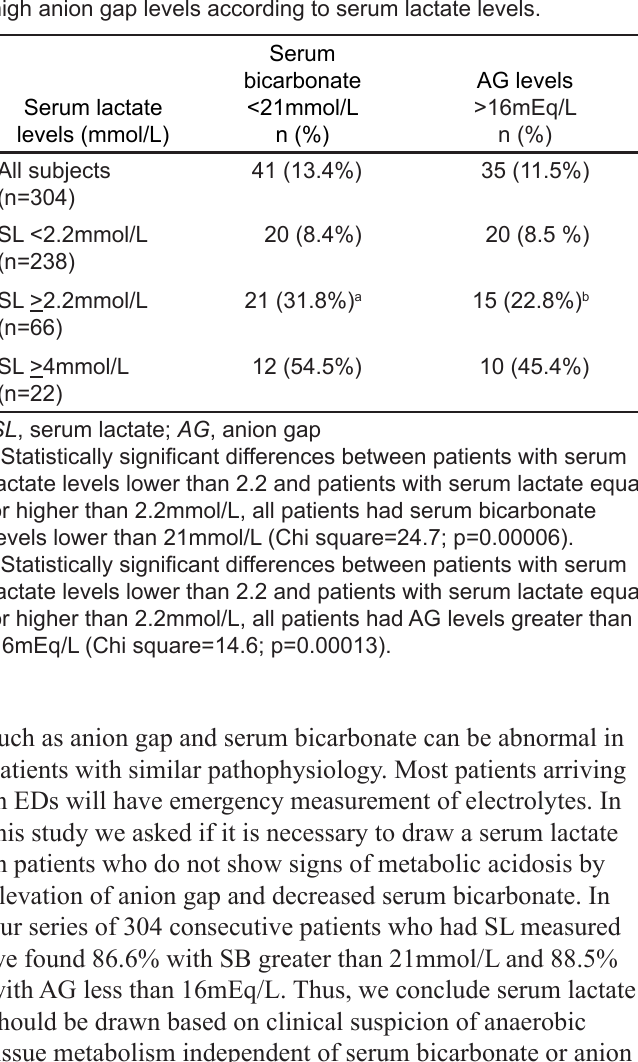
Table 2. Distribution of patients with low serum bicarbonate and high anion gap levels according to serum lactate levels.